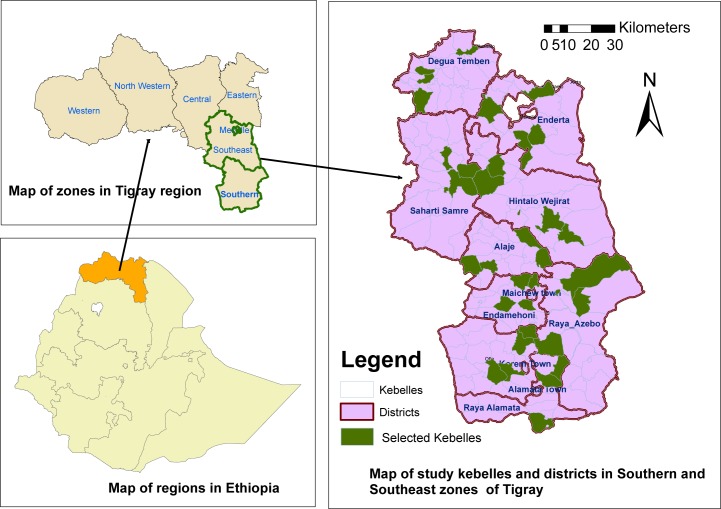
Geographical map of study districts and kebelles in South and Southeastern zones of Tigray region, 2016.